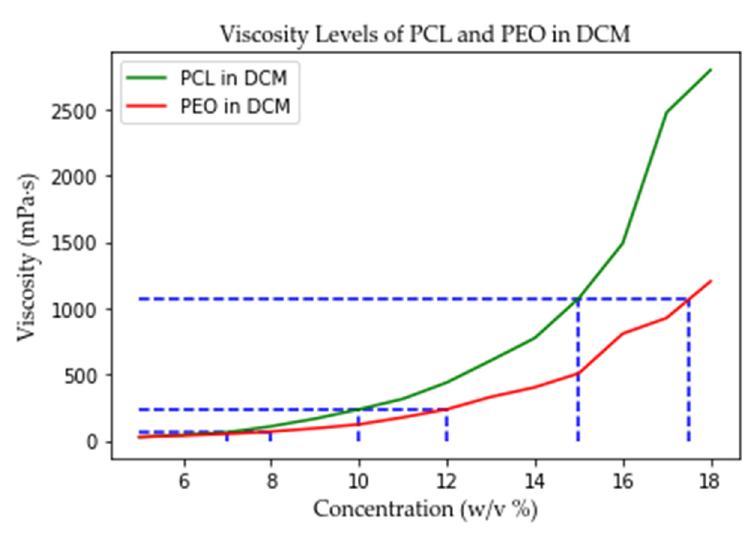
Figure 3. The viscosity of PCL and PEO.